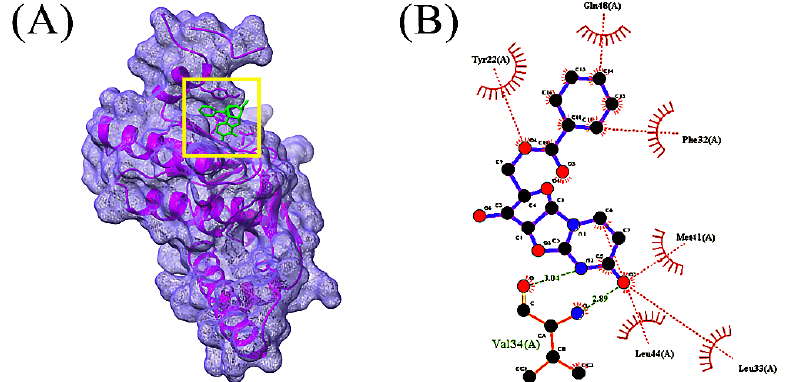
Figure 5. Docking simulation between protein-ligand interactions of caseinolytic proteases (Clp) enzymes Bacillus subtilis (PDB ID: 7M1M) and oxalic acid, cyclohexylmethyl tridecyl ester, where ( A ) Surface view using Chimera (binding pocket), ( B ) 2D view using LigPlot+.